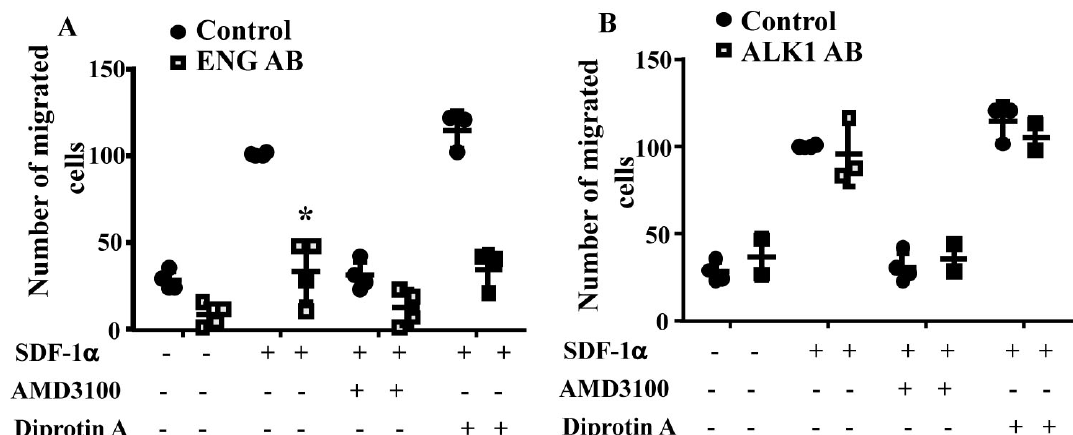
Figure 2. ENG antibody (ENG AB) pre-treatment reduced MNC-migration toward SDF-1α. A. Quantification of the migration of ENG antibody pre-treated normal MNCs. Controls are MNCs pretreated with corresponding control IgG. *: P < 0.001 versus control IgG treated cells. B. Quantification of the migration of ALK1 antibody pre-treated normal MNCs. Controls are MNCs pretreated with corresponding control IgG. N = 4 for control IgG treated groups; N = 4 for ENG antibody treated groups; and N = 3 for ALK1 antibody (ALK1 AB) treated